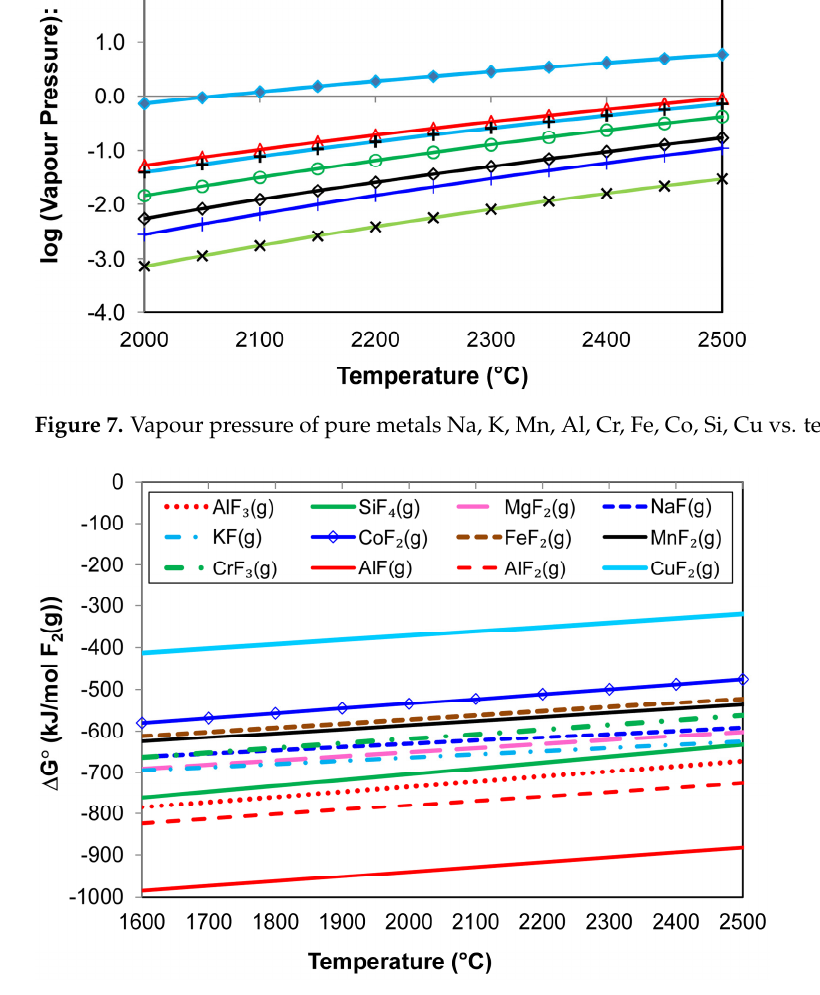
Figure 8. Standard Gibbs free energy values of reactions similar to Equations (6)–(9).